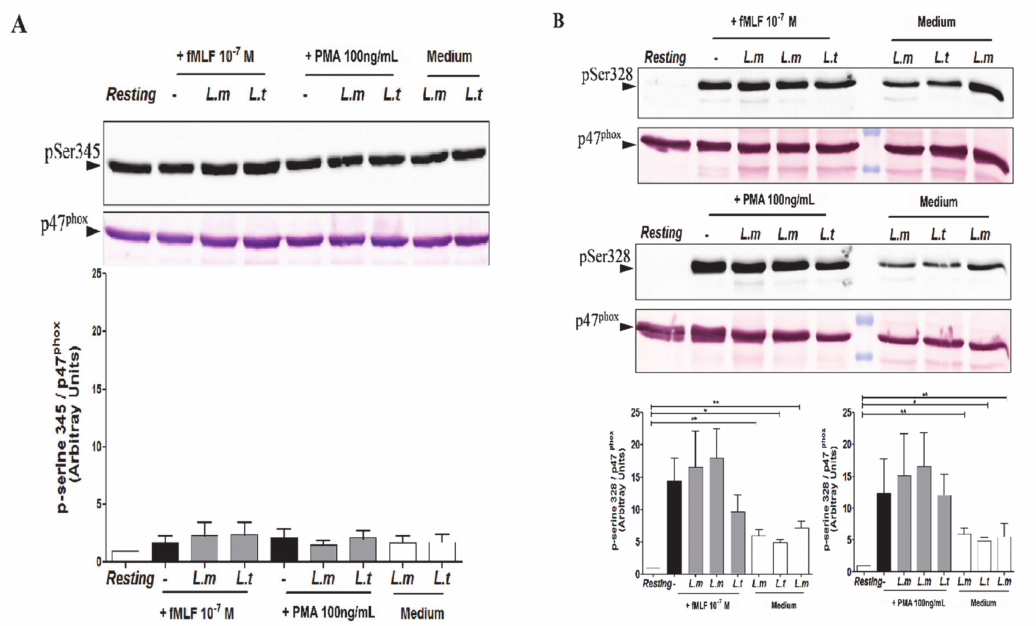
Figure 5. Effect of L. major and L. tropica promastigotes on the p47 phox phosphorylation of Ser328 and Ser345. An additional L. major strain was used in these experiments: (MHOM/MA /2010/L104). PMNs (4 × 10 6 ) were infected at a 5:1 ratio, then stimulated with fMLF (10 − 7 M) and PMA (100 ng/mL). PMNs were infected and non-stimulated (Medium), uninfected and stimulated ( − ), uninfected and non-stimulated (Resting), are used as controls. Cell lysates were subjected to SDS– PAGE and analyzed by Western blot using specific rabbit polyclonal antibodies ( A ) anti-phospho-Ser345 p47 phox and ( B ) anti-phospho-Ser328 p47 phox . The blots were re-probed with rabbit anti-p47 phox antibody as a loading control. The ratio of phospho-p47 phox to the total amount of p47 phox was quantified using Image J.Values. Results are expressed as Mean ± SEM from 5 independent experiments. Data were analyzed using a One-way ANOVA test with Tukey’s post-hoc test for multiple comparisons. * p < 0.05; ** p <